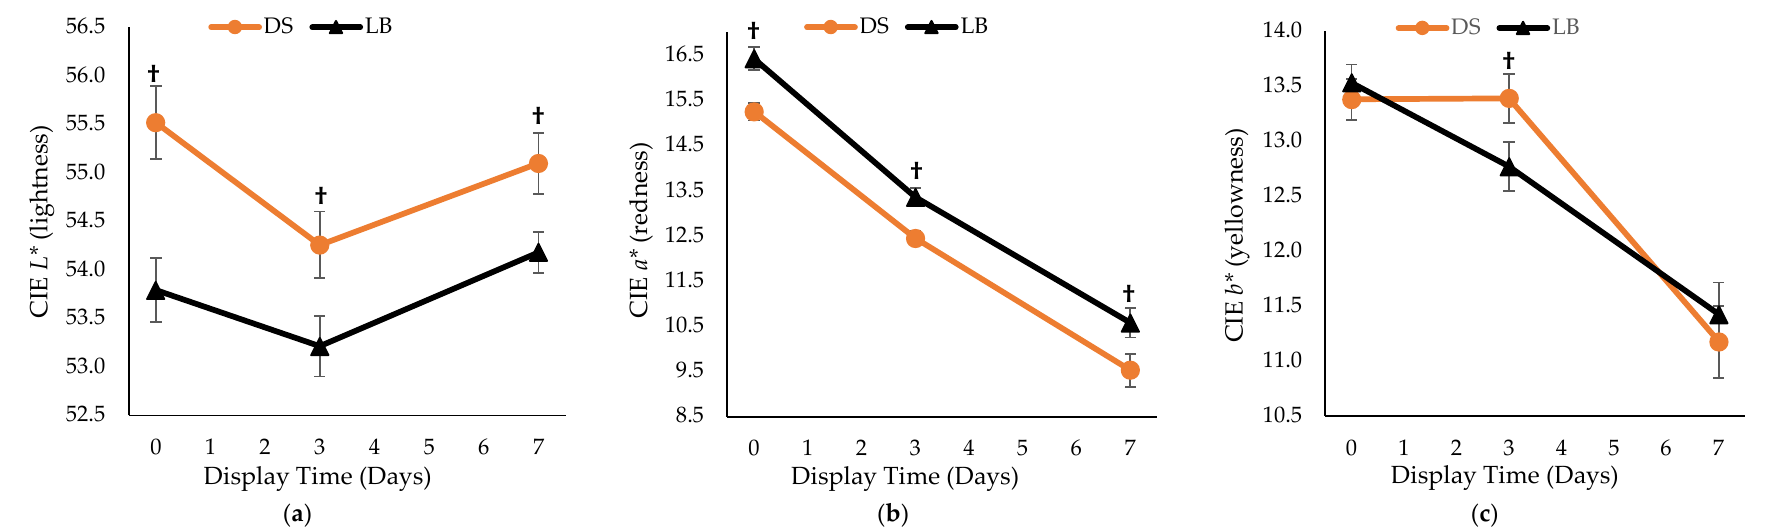
Figure 5. Effect of breed on D65 instrumental color attributes: ( a ) CIE L* (lightness); ( b ) CIE a* (redness); ( c ) CIE b* (yellowness). DS = Duroc-sired and LB = Large Black pigs. † Means of similar display time lacking the superscript differ due to breed ( p < 0.05).